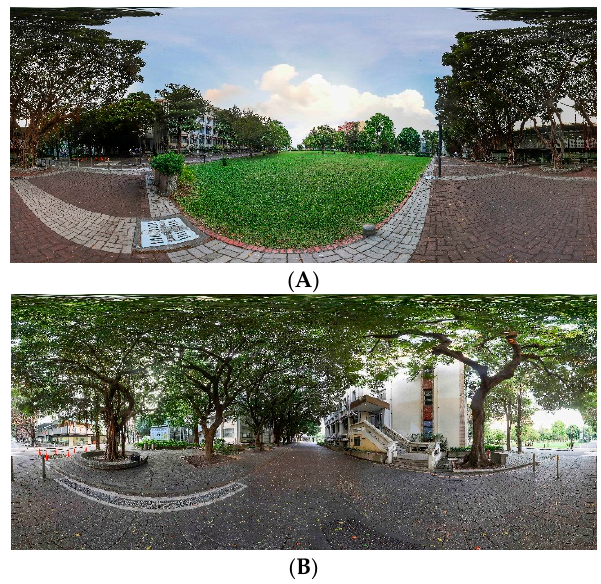
Figure 13. Cases for comparing di ff erent overlap ratios and RMSEs after image stitching. ( A ) Case 1; ( B ) Case